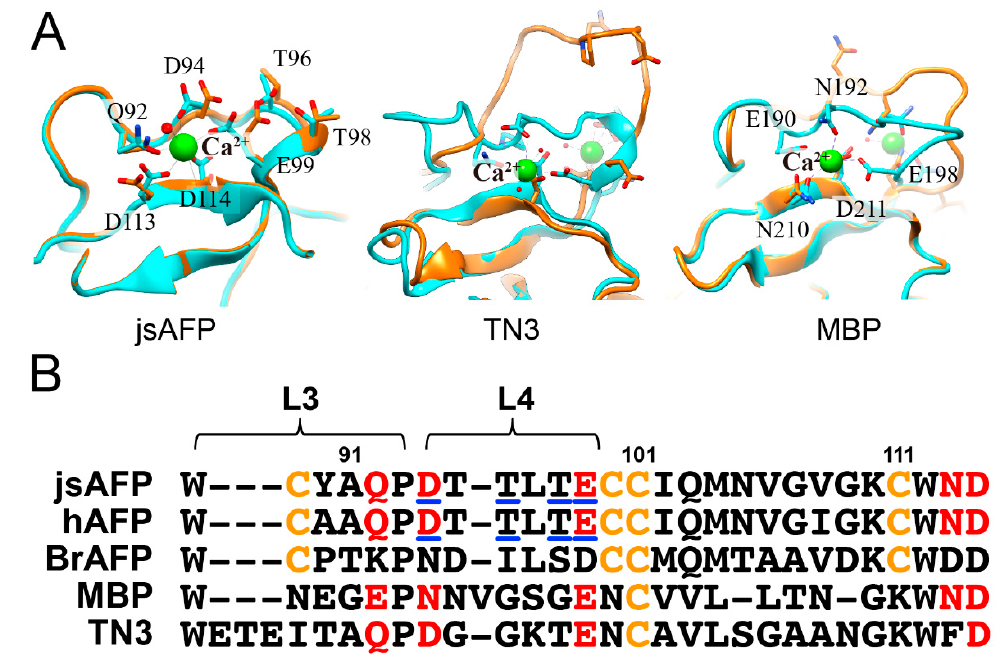
Figure 4. Structural comparison between jsAFP and the other C-type lectins. ( A ) The structures of a Ca 2 + -binding loop of jsAFP, tetranectin3 (TN3) and a mannose-binding protein (MBP). The backbone structure represented by ribbons colored cyan and orange for the Ca 2 + -bound and -free structures, respectively. The Ca 2 + -binding residues are shown in sticks, and Ca 2 + ions are represented by green spheres. The backbone conformation of jsAFP is not changed by the releasing of Ca 2 + , while that of the others (TN3 and MBP) with 2 mol of Ca 2 + is moved away from interior (cyan) to outside (orange). ( B ) Alignment of the amino acid sequence involved in the Ca 2 + -binding site (L3 and L4) of jsAFP, hAFP, BrAFP, MBP, and TN3 categorized into the C-type lectin. The residues known to participate in the disulfide-bonds and the Ca 2 + -binding site are colored in yellow and red, respectively. The putative ice-binding residues are underlined for